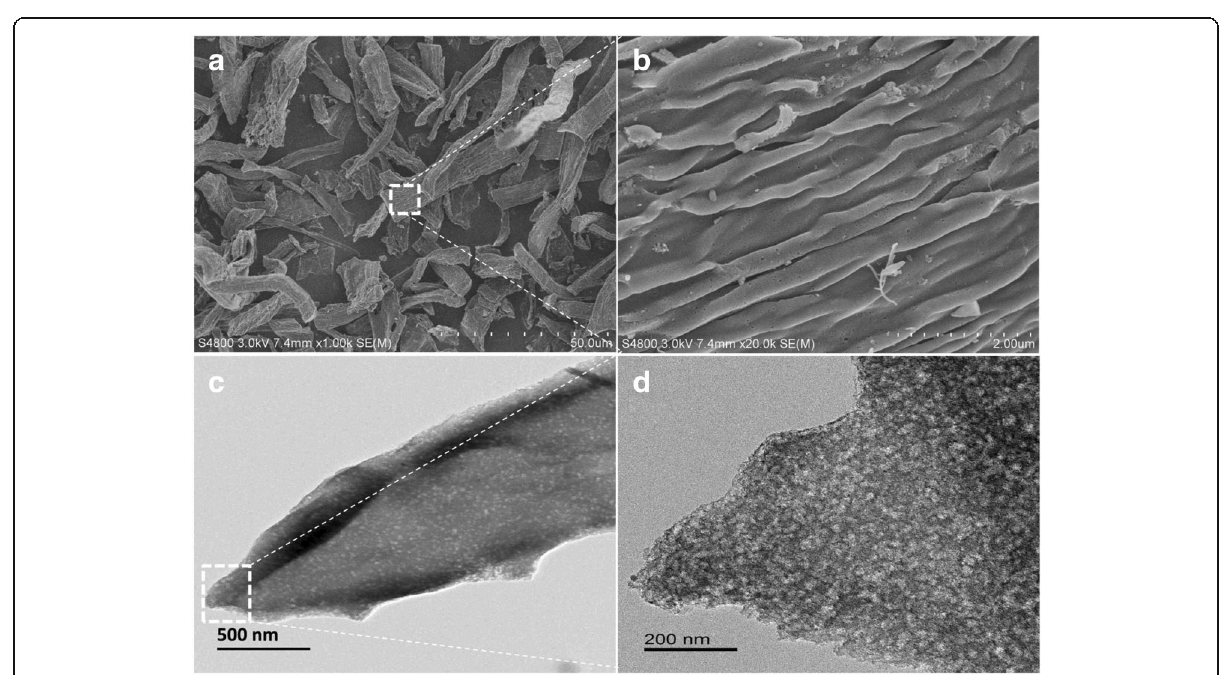
Fig. 2 The SEM ( a , b ) and TEM ( c , d ) images of